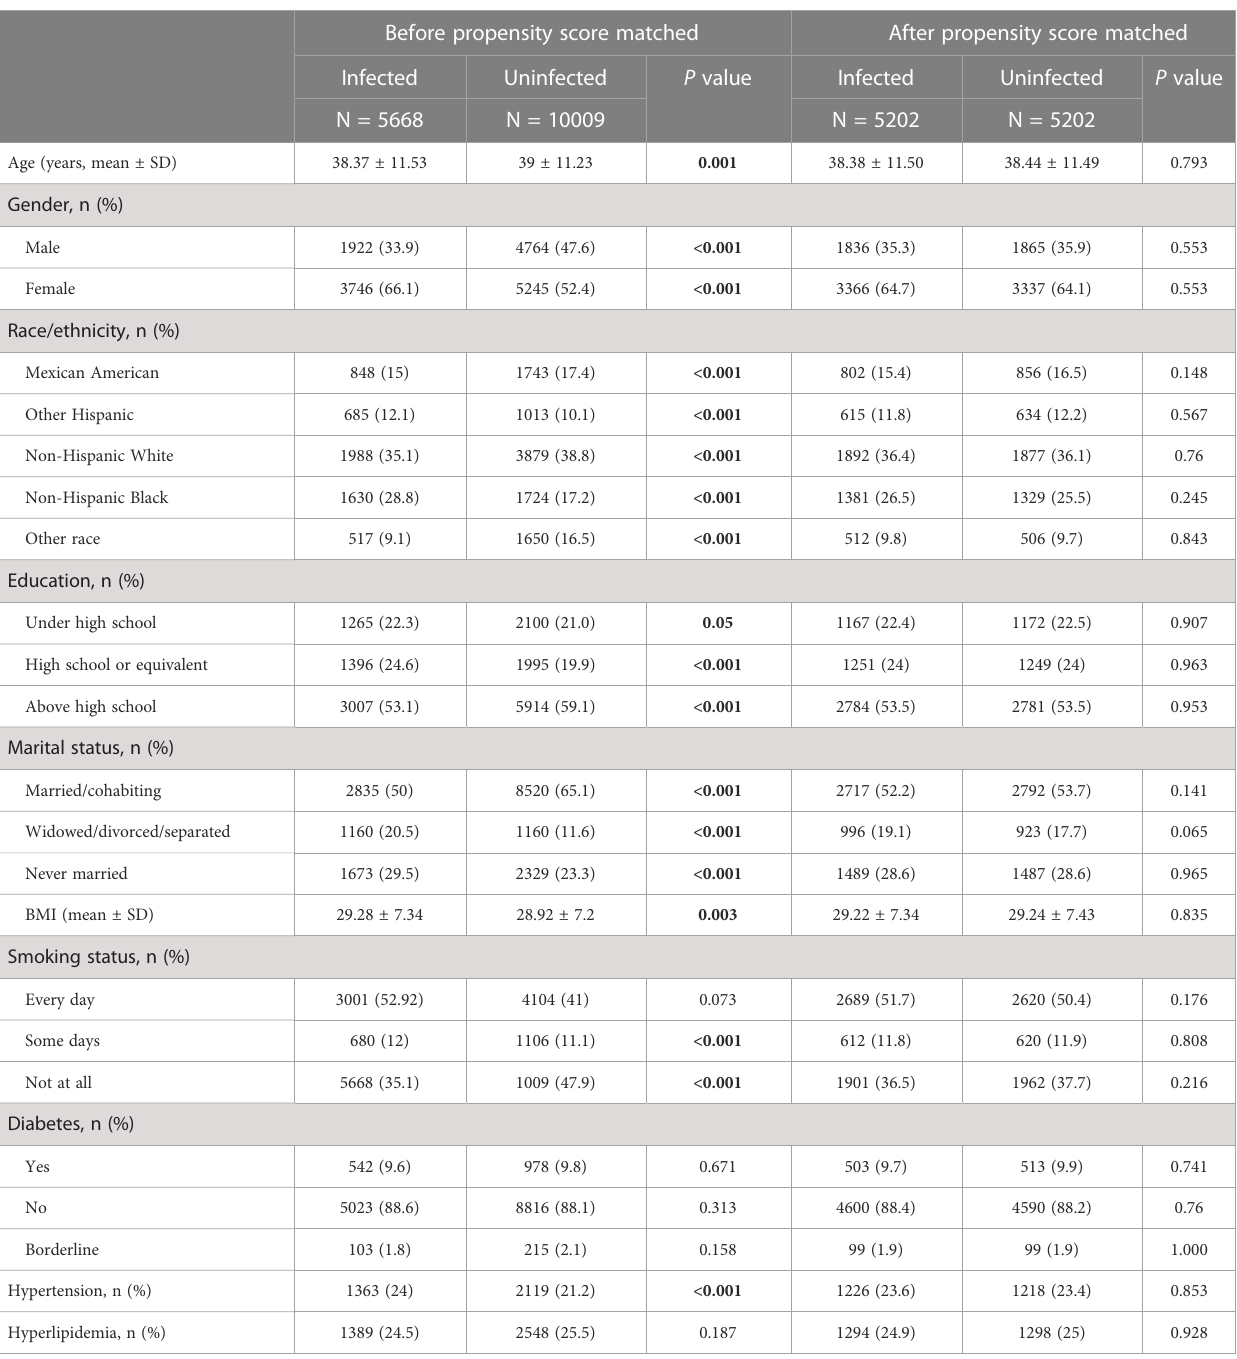
TABLE 1 Demographic characteristics of HPV infection cohort before